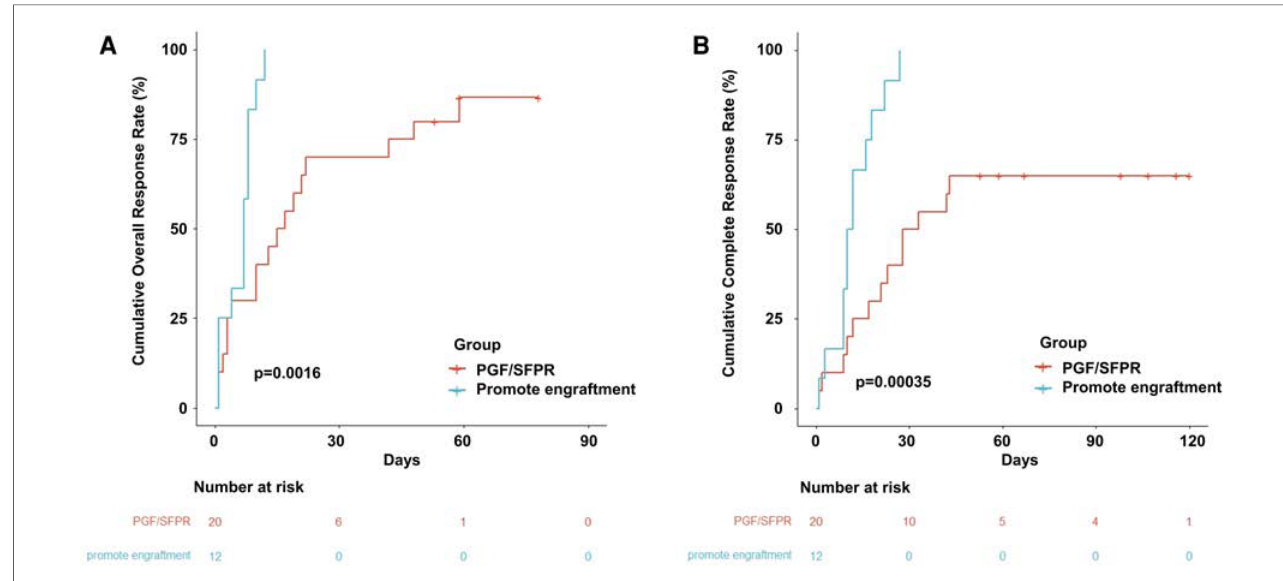
FIGURE 3 Cumulative event incidence. ( A ) Cumulative overall response rate. ( B ) Cumulative complete response